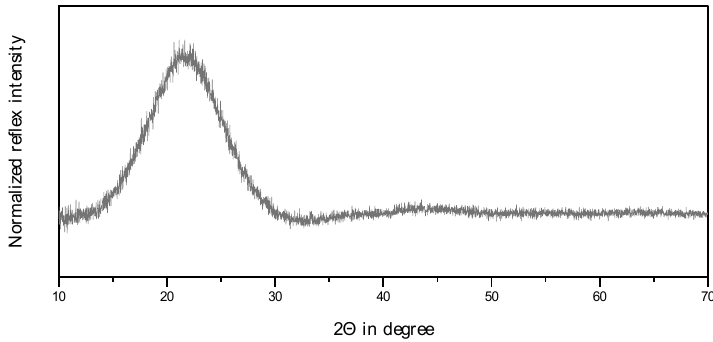
Figure 4. P-XRD of the carrier Aerosil380 normalized to the highest reflex.